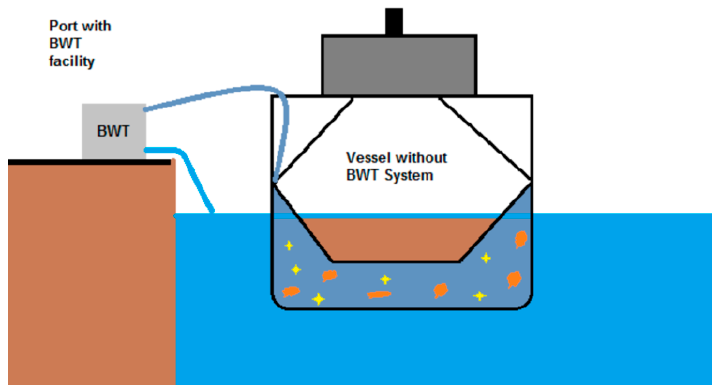
Figure 3. Harbor’s facility—ballast water treatment (BWT) container.